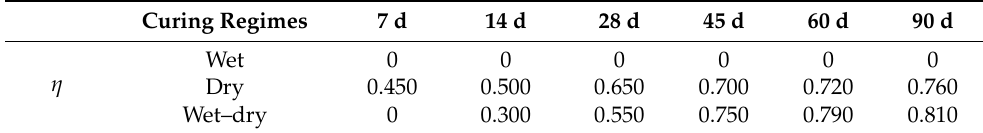
Table 6. The degree of polymerization calculated by Equations (6) and